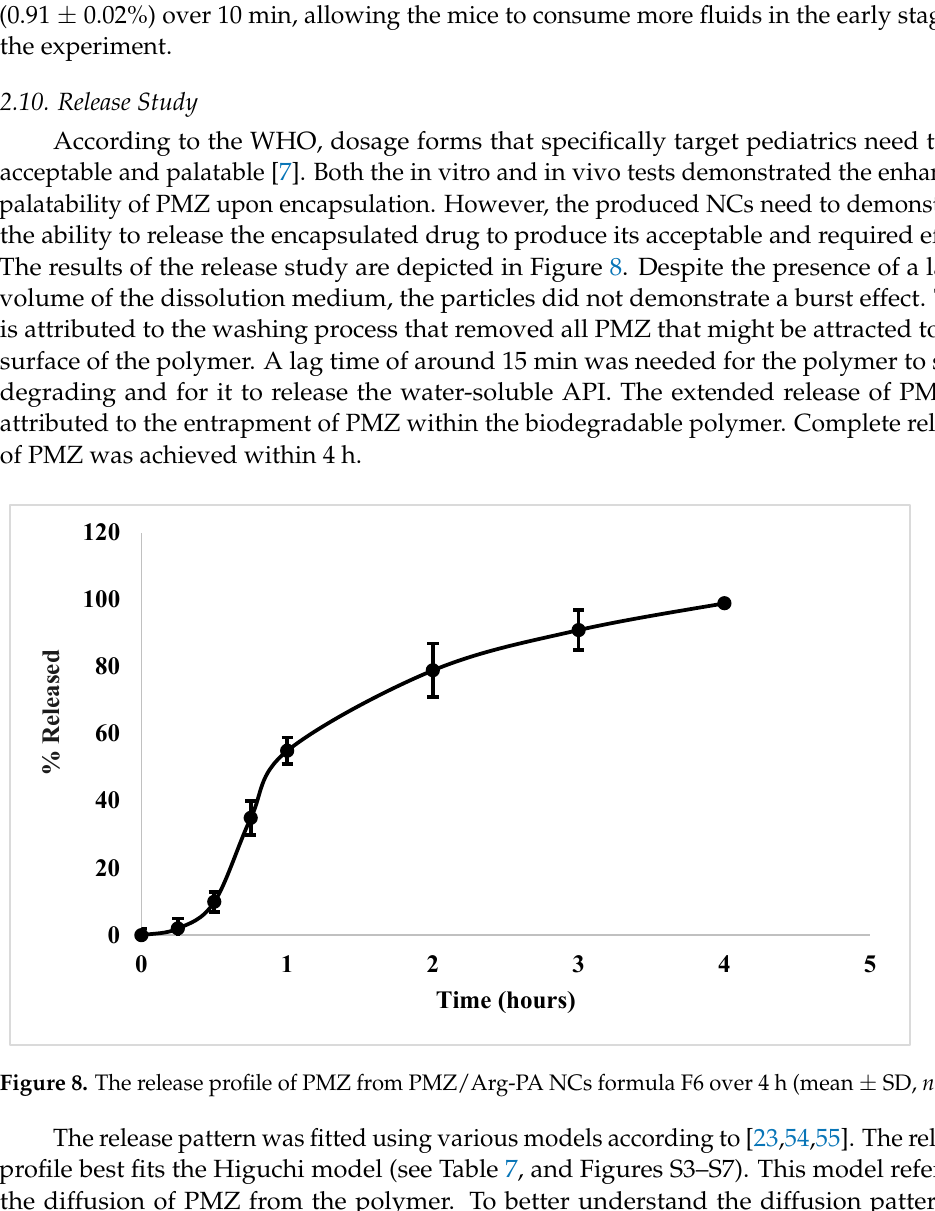
Table 7. The equation coefficients of determination (R 2 ) and the “ n ” value for each mathematical model for PMZ. The Fitted Mathematical Model